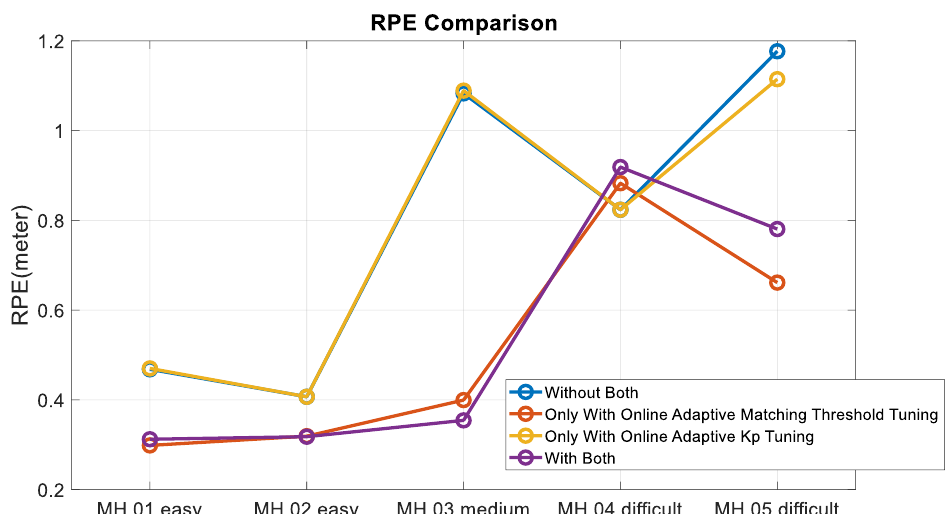
Figure 20. Euler angle accuracy comparison.